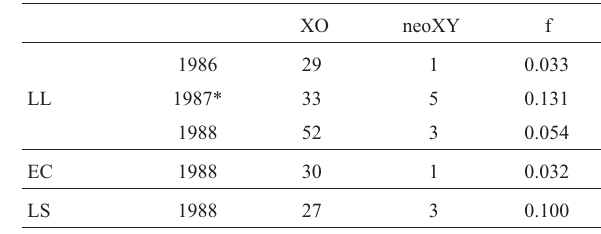
Table 4 - Fusion (f) frequencies in different karyomorphs of Sinipta dalmani males from the “Los Loros” (LL), “Los Sauces” (LS) and “El Camino” (EC)